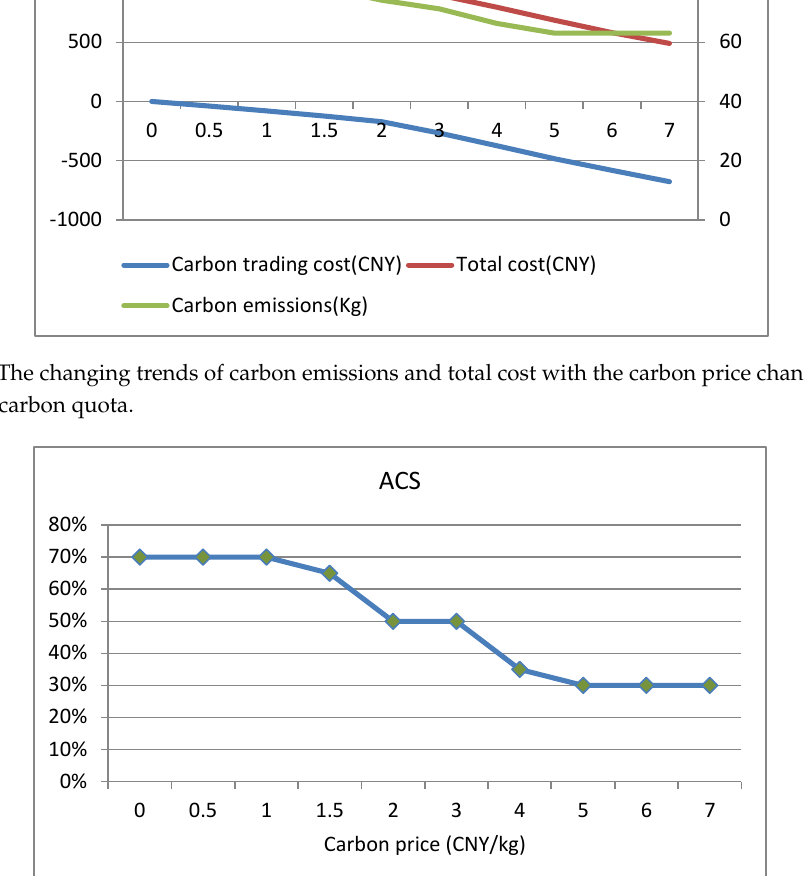
Figure 7. The changing trend of average customer satisfaction with the increase in carbon price under sufficient carbon quota.